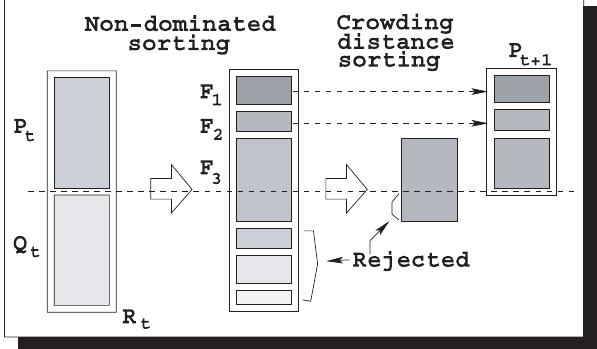
Fig. 1. Schematic of the NSGA-II